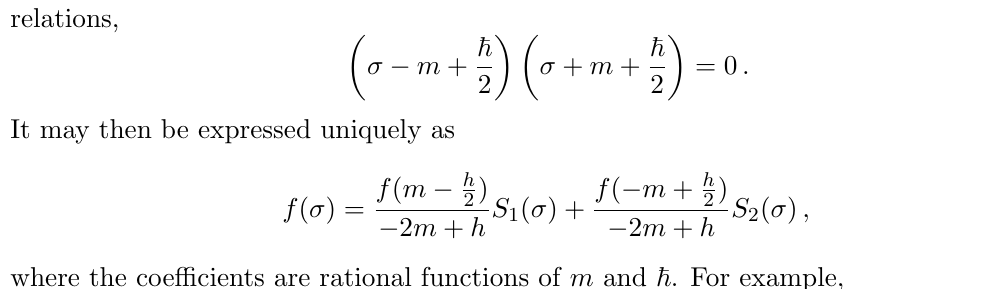
Figure 11. The subspaces de(cid:12)ned by setting one of the chiral multiplets X and the polynomial representations of the Poincar(cid:19)e dual cohomology classes. For future reference, we have included the stable basis labels to be introduced in section